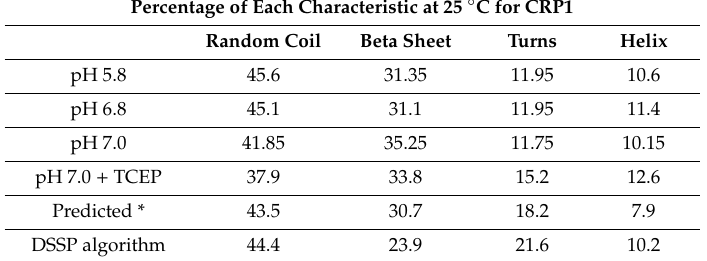
Table 1. Secondary structure of CRP1 broken down into the four main types of secondary structure identified by DichroWeb. * Predicted percentages were calculated from the 8-state protein secondary structure (SS 8 ) predicted model produced by NetSurfP-2.0, with bend collapsed into random coil structure. Percentages of secondary structures of the modeled CRP1 three-dimensional structure were calculated using the DSSP algorithm [28,29].